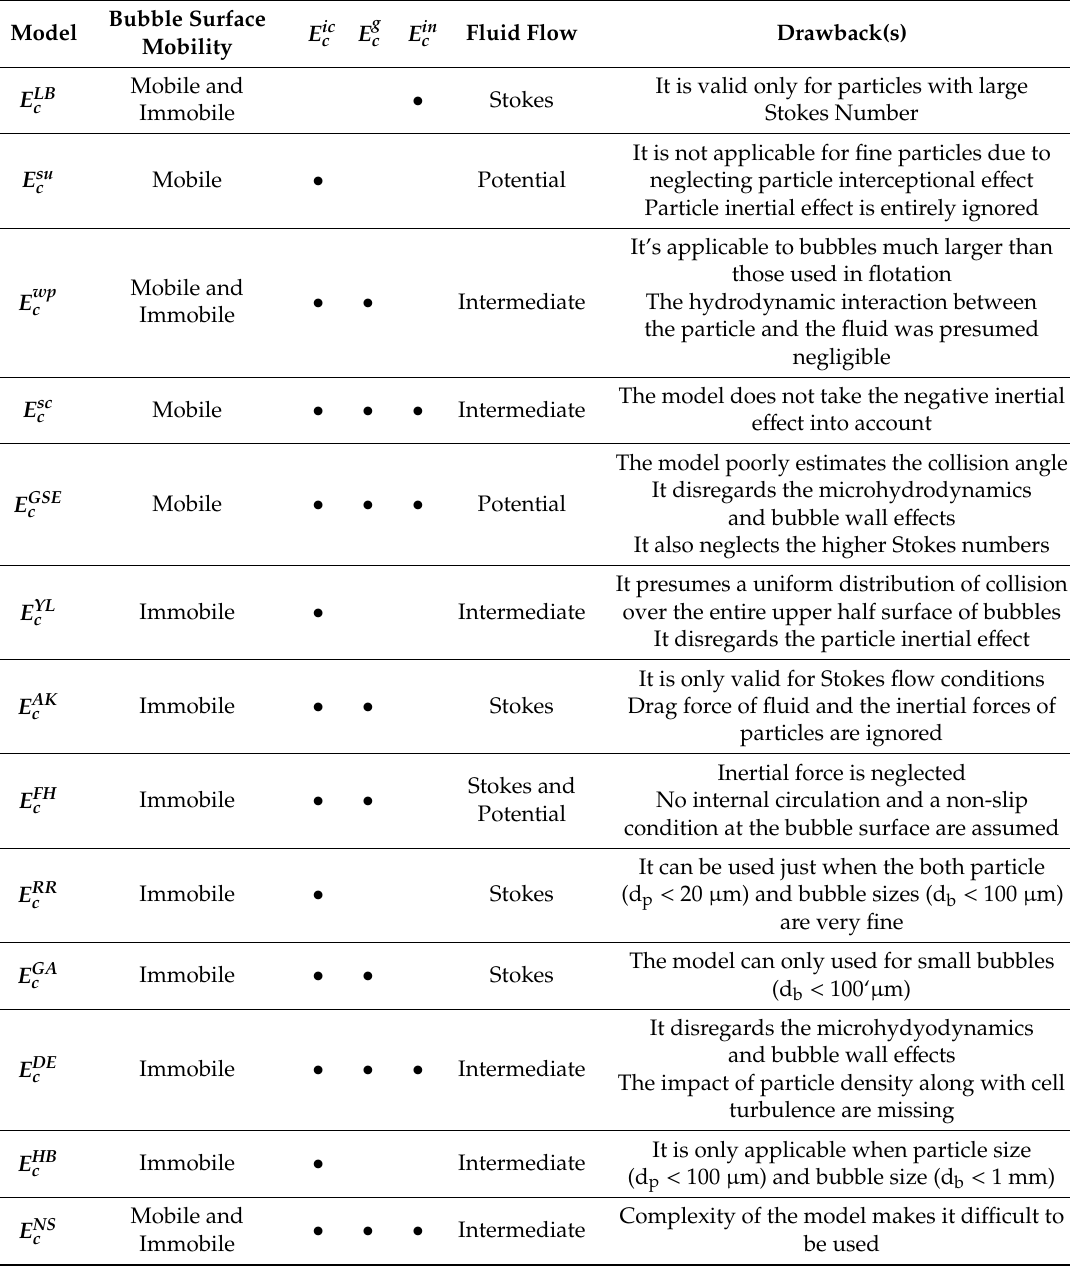
Table 1. Hassanzadeh’s review of the main assumptions and drawbacks of di ff erent analytical and numerical models representing particle–bubble collision e ffi